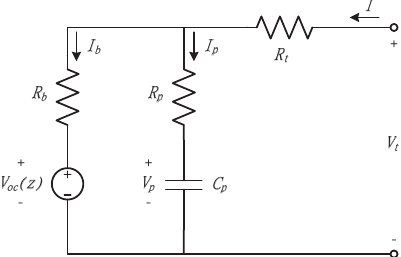
Figure 1. Equivalent circuit-based battery model.